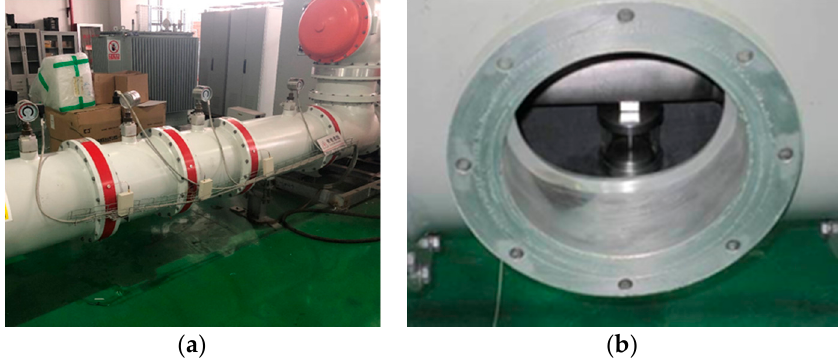
Figure 5. The experimental site. ( a ) Photo of the GIS; ( b ) A defect model placed in the